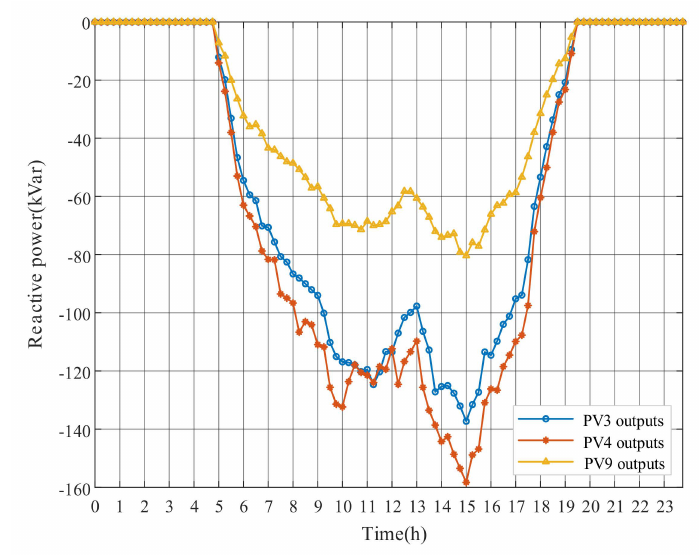
Figure 9. PV reactive power outputs with DRM strategy.